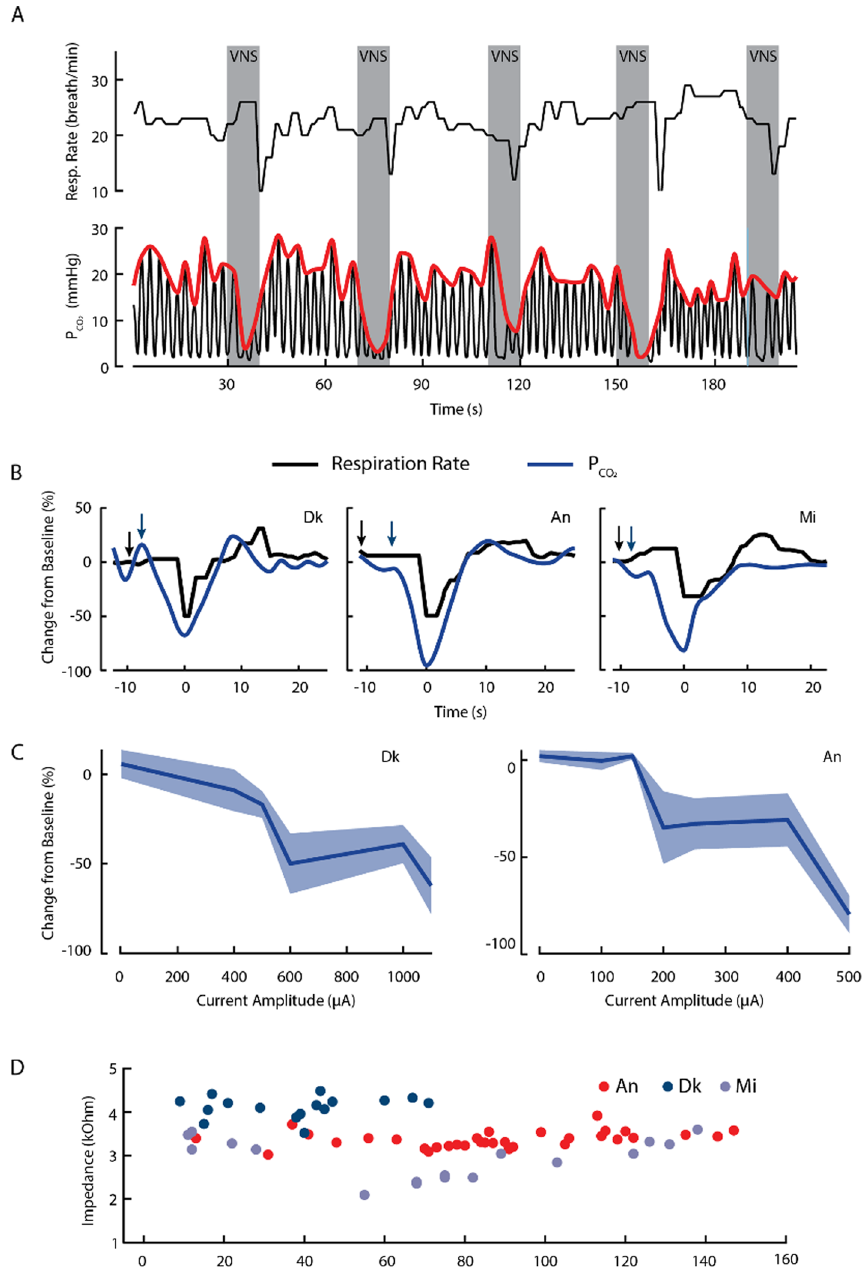
Fig. 2 Awake verification of target engagement and electrode reliability/stability. A Representative measurements of heart rate, respiration rate and partial pressure of carbon dioxide (P CO2 ) during consecutive periods of VNS (10 s on, 30 s off) for NHP Dk 39 days post implant. Gray bars denote the period VNS is turned on. Similar to the anesthetized, intraoperative testing, we see noted parasympathetic effects on the rate of respiration. This depressive effect on respiration is plainly visible in the raw P CO2 time series (black) and its envelope (red trace). B Average change in respiration rate (black trace) and P CO2 (blue trace) for NHPs Dk, An and Mi measured 39, 86 and 122 days post implant, respectively. Stimulation amplitudes were 1000µA, 500µA and 1000µA for Dk, An and Mi, respectively. Again, we find robust parasympathetic effects on respiration but not heart rate, with the most profound effect being seen in P CO2 . Arrows represent the average time VNS was applied to evoke these average responses. C Dose response curves demonstrating changes in P CO2 as a function of stimulation current amplitude. Greater levels of stimulation resulted in larger decreases in P CO2 during stimulation. D Impedances of the VNS electrode, measured at 1 kHz, remain stable throughout the duration of the